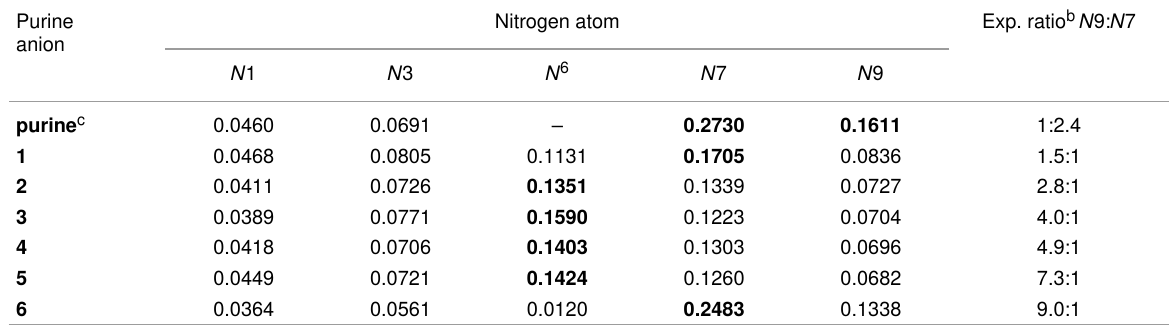
Table 1: The condensed Fukui functions f − (based on NBO atomic charges) for nitrogen atoms in the purine anions calculated at the (U)B3LYP/6- 31+G(d) method. a Purine anion